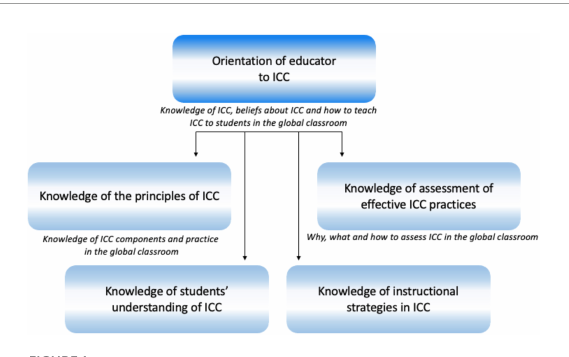
FIGURE1 Components of PCK for implementing ICC in global classrooms. The Orientation of the educator to ICC including beliefs about the goals and purposes of teaching ICC and how to instruct students in ICC within global classrooms is central to an educator’s PCK. The orientation of the educator to ICC is instructed by 4 other linked, yet diverse elements; (1) knowledge of ICC principles and practice (2) appreciation of the knowledge of the Students’ understanding of ICC synthesized with (3) knowledge of appropriate instructional strategies in ICC, and (4) knowledge of efficient assessment practices to effectively assess the Student’s understanding of ICC in the global